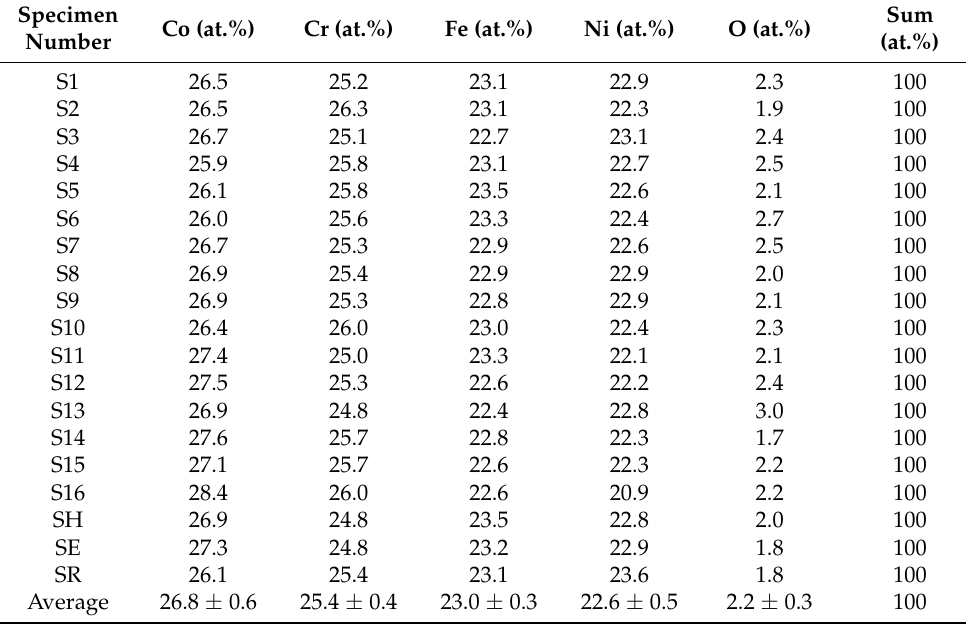
Table 3. Chemical composition (at.%) of each film measured by SEM-EDS.